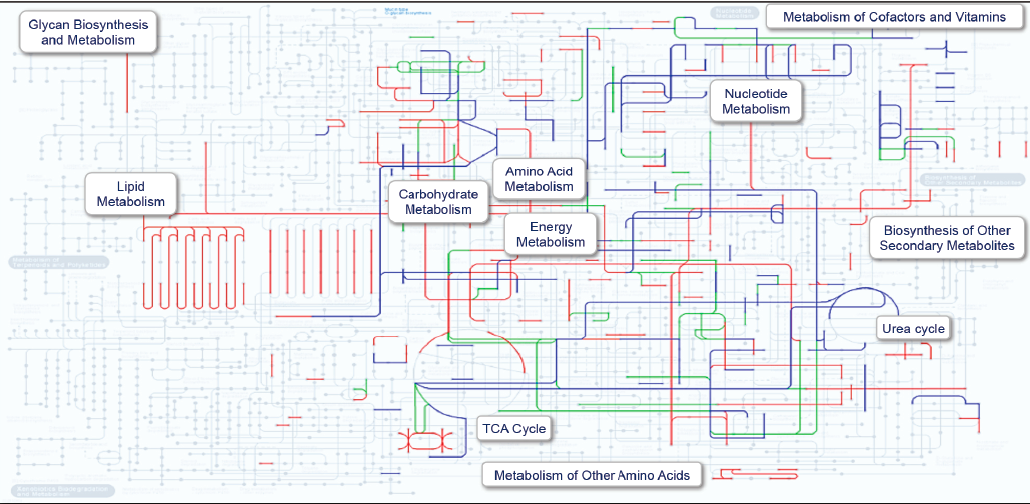
Figure 5. KEGG Pathway analysis using protein metaclusters and corresponding spectral counts. Pathways highlighted in red are more abundant in the antibiotic treated subject. Those in blue are less abundant while green indicates equivalence.